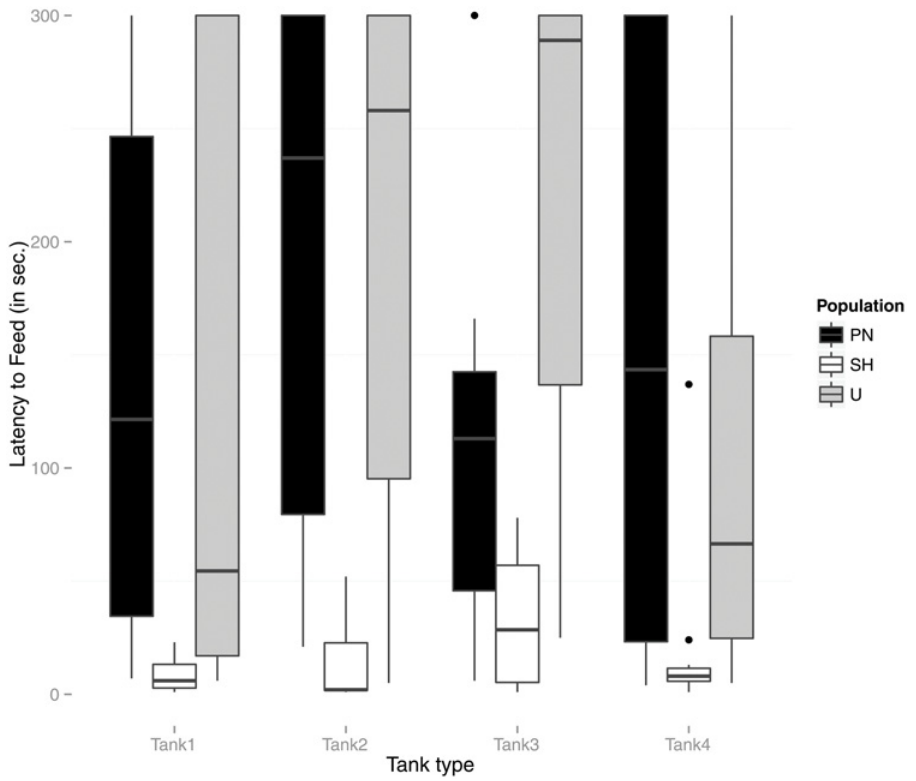
Fig 1. Box-plot representing population-wise measurements of Latency to feed (in seconds) in each tank treatment type (tank 1, tank 2, tank 3, and tank 4). Tank 1 (Flow, no vegetation), 2 (No Flow, vegetation), 3 (No flow, no vegetation) and 4 (Flow, Vegetation). Outliers are shown as solid